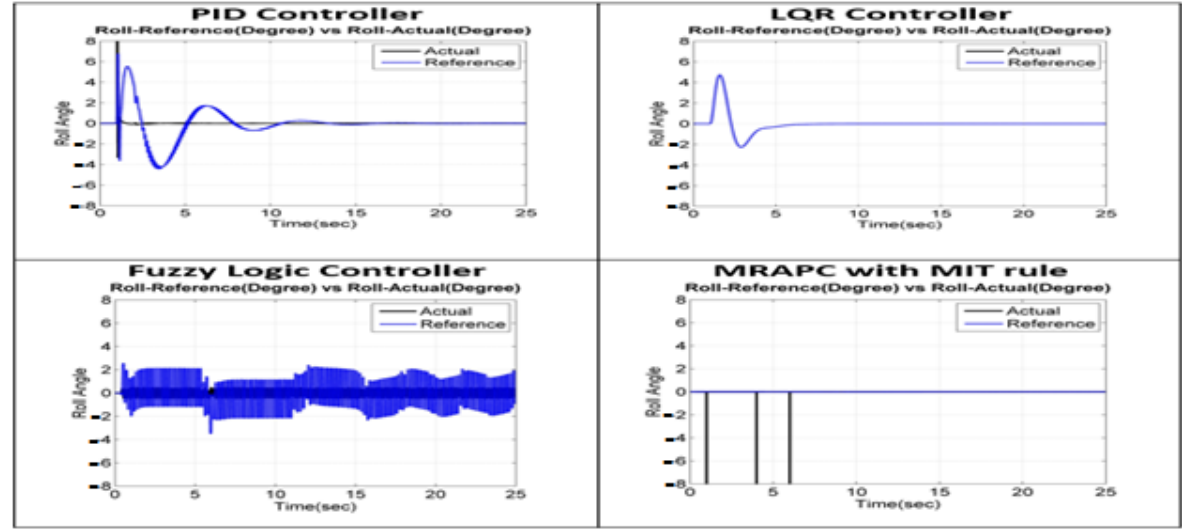
Figure 16. Roll ( ϕ ) Control result depending on step input for all control systems. Figure 16. Roll ( φ ) Control result depending on step input for all control